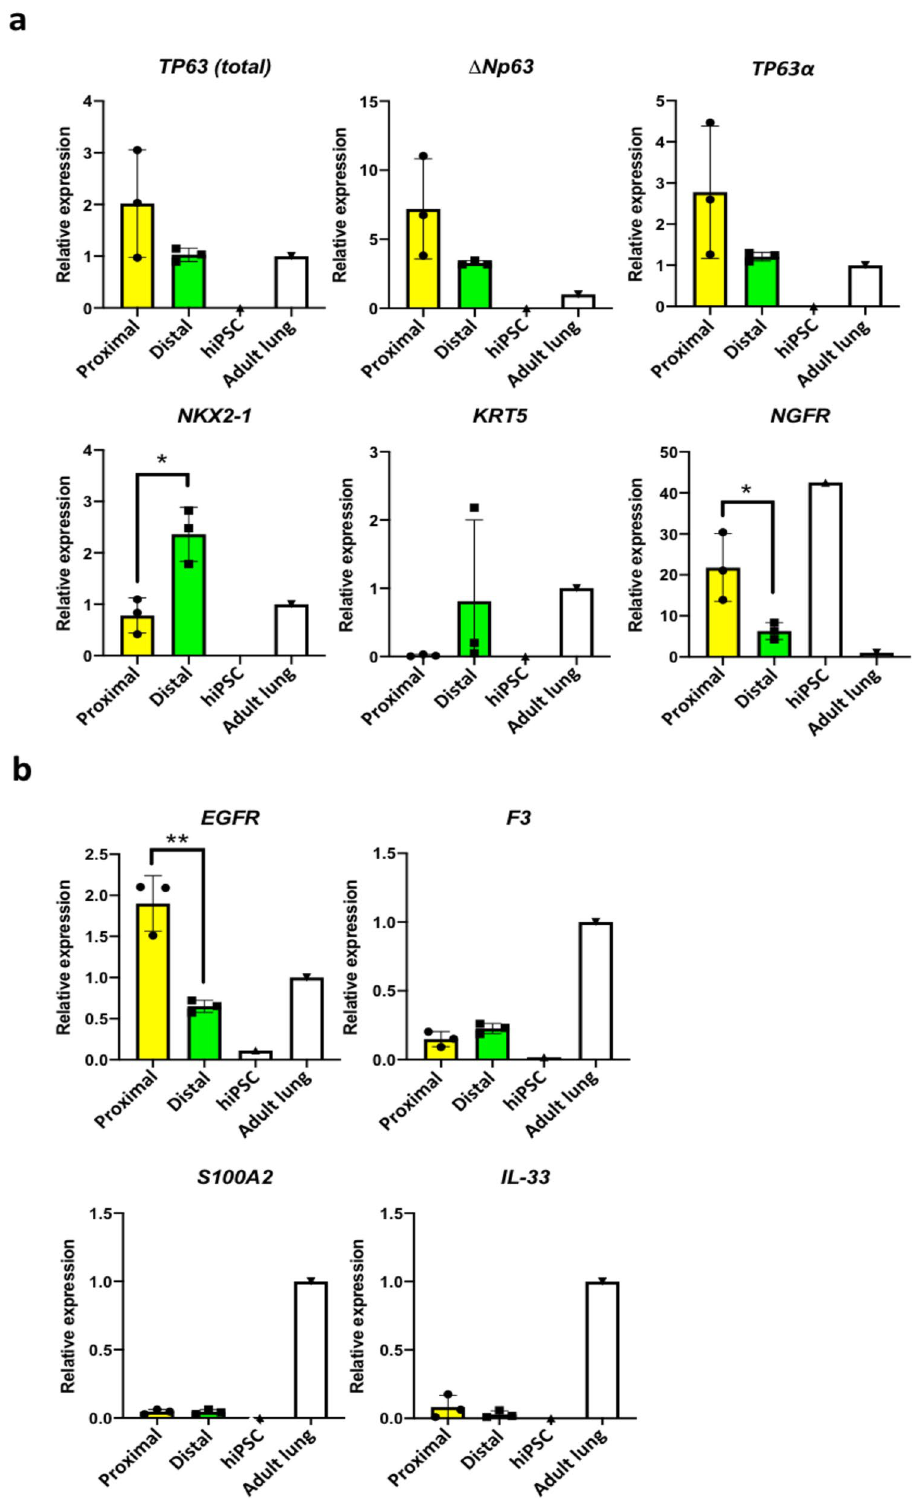
Figure 5. Gene expression analysis of NKX2-1 GFP ;TP63 tdTomato hiPSC-derived lung organoids. ( a ) QPCR analysis of lung marker NKX2-1 and basal cell markers TP63 (total), ΔNp63, TP63α , KRT5 , and NGFR . Expression levels were normalized to housekeeping gene, ACTB. n = 3. * p < 0.05. t test. ( b ) QPCR analysis of additional markers identified by Miller et al . ( 2020) 50 to be associated with basal cells. Expression levels were normalized to ACTB . n = 3. **p < 0.01. All graphs were made and statistical analyses were done using GraphPad Prism 8.0 (GraphPad Software Inc., San Diego, CA, USA) (www.graph